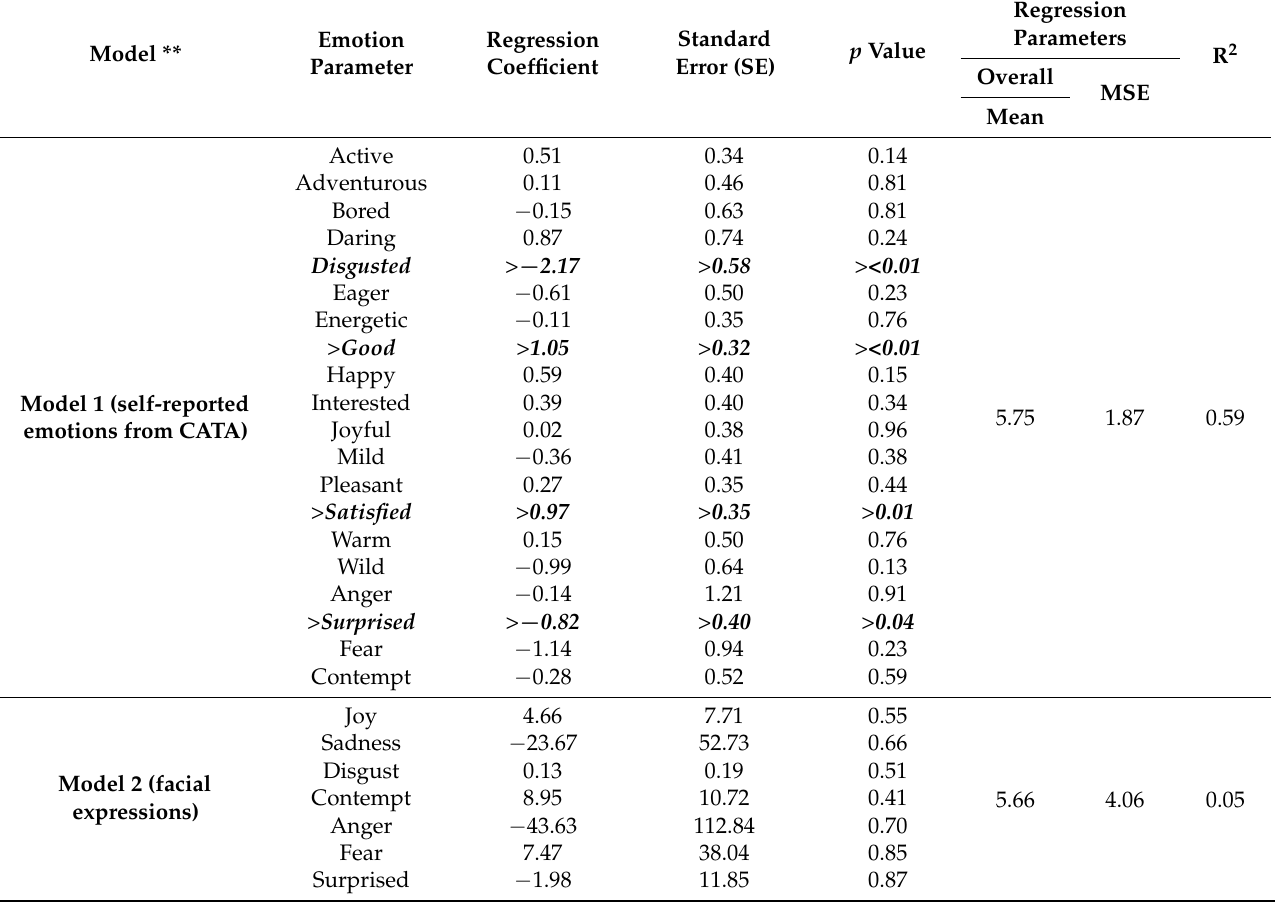
* Data points were fitted using a linear regression model with overall liking as the response variable. MSE represents the mean square error value. R 2 is the coefficient of determination of the regression models. ** Bold italicized values indicate that the parameter was significantly different from 0 ( p <